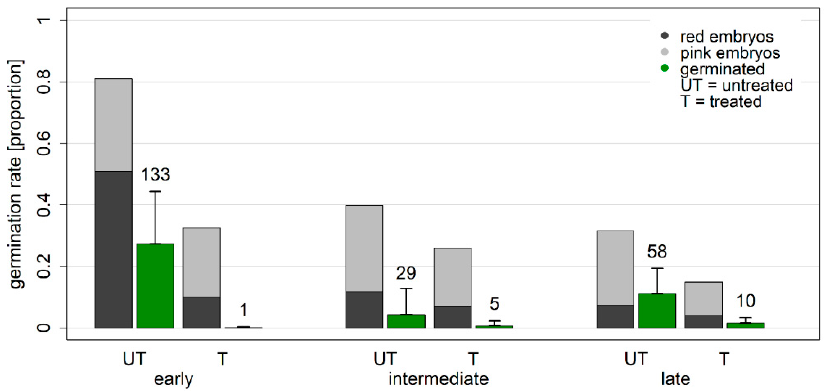
Figure 4. Comparison between actual and potential germination rate of Heracleum mantegazzianum seeds. Germination rate for different harvest times (2 weeks (early), 5 weeks (intermediate), 8 weeks (late) after flowering) and treatments (UT: Untreated; T: Incubated in 35 °C water bath for 48 h). Mean number of germinated seeds (green bars, n = 900 seeds per harvest time and treatment) and maximum number (whiskers and numbers, n = 300 seeds per individual). Potential germination rate calculated from viable (red) and damaged (pink) embryos (grey bars, values of water bath tests for survival after 48 h at 35 °C, Table 1, UT: n = 400, T: n = 200).